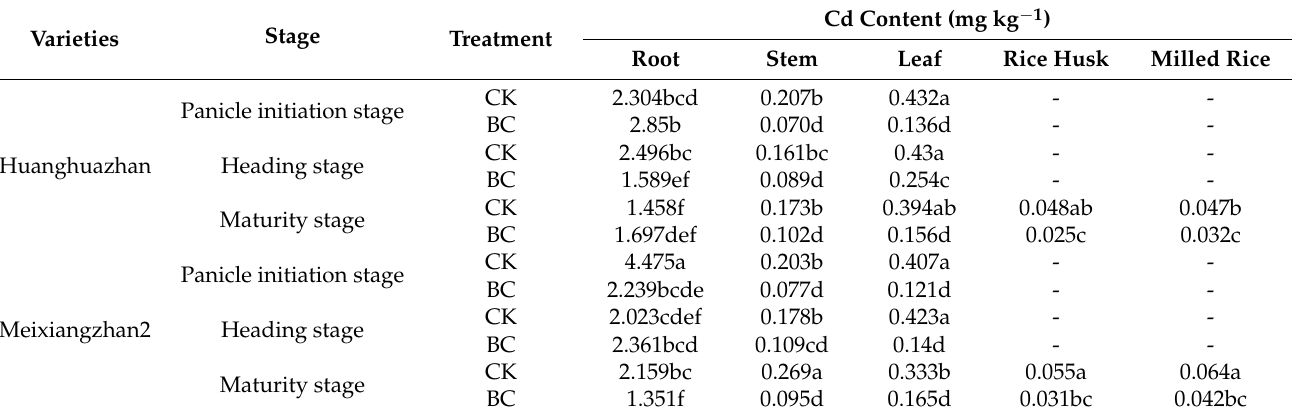
Table 1. The content of Cd in different organs of rice as affected by biochar treatment.